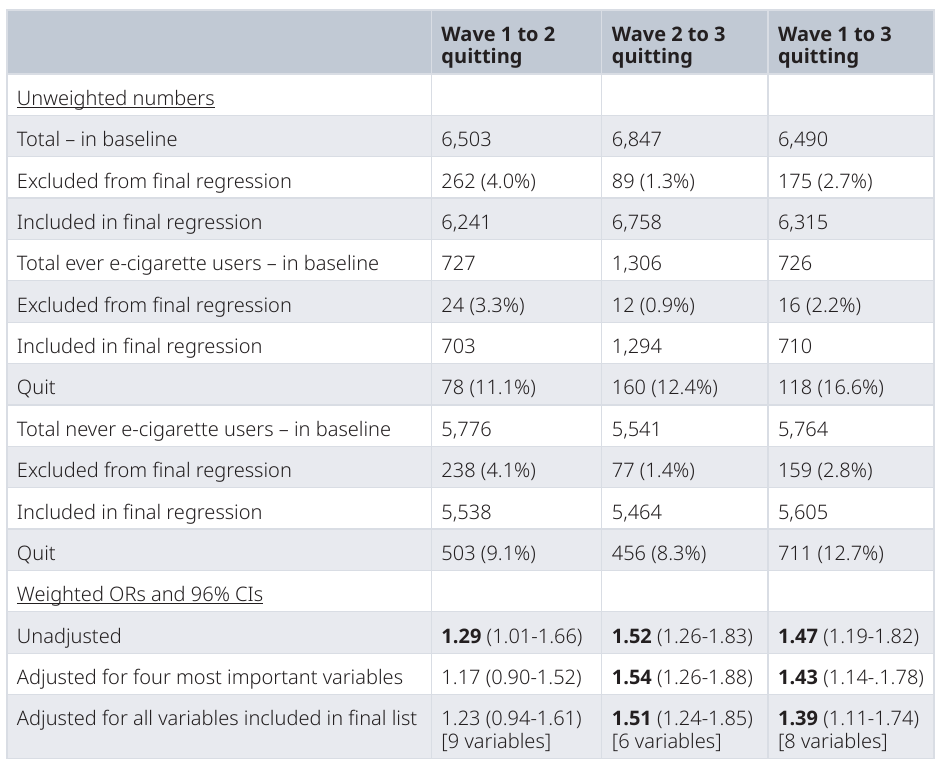
Table 2. Effect of adjustment on the OR (95% CI) for the relationship of ever regular e-cigarette use a to quitting.